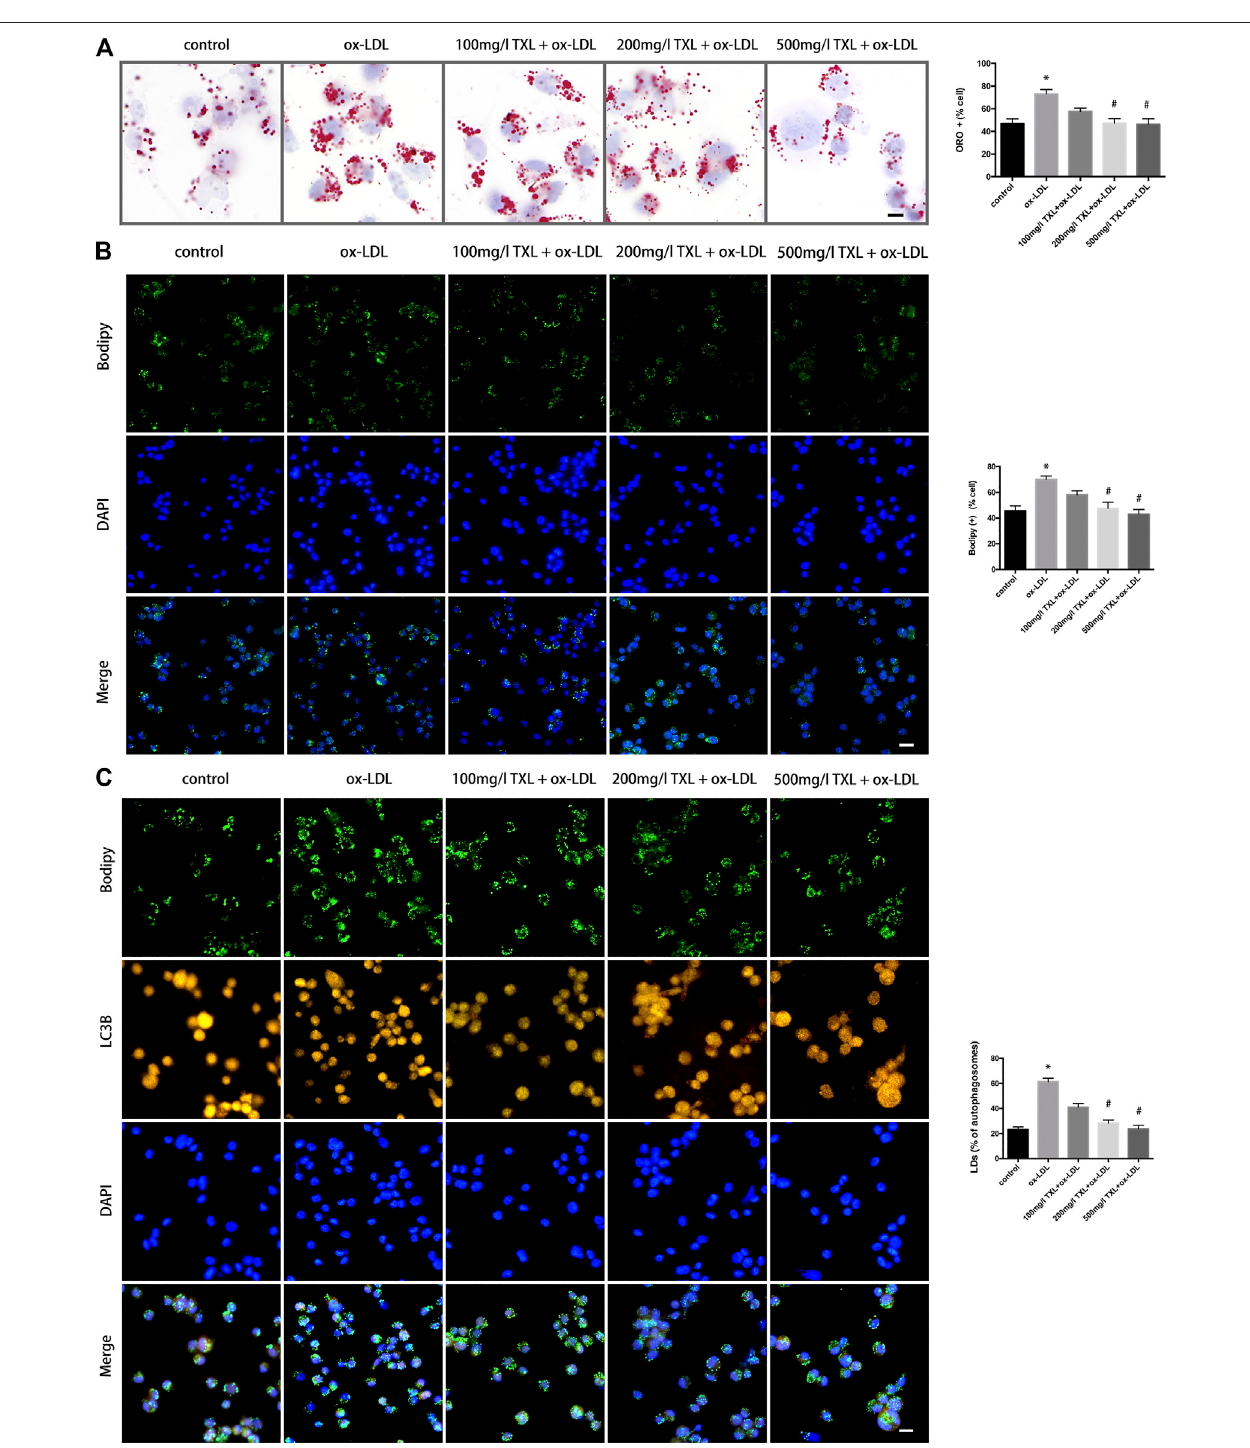
FIGURE 2 | TXL treatment inhibited lipid deposition in THP-1 Macrophages. (A) Cell oil red O detected the effect of TXL on ox-LDL-induced macrophage lipid deposition, n (cid:2) 3, bar (cid:2) 10 μ m, * p < 0.05 vs. control, # p < 0.05 vs. ox-LDL. (B) Cell Bodipy staining detected the effect of TXL on ox-LDL-induced macrophage lipid deposition, n (cid:2) 3,bar (cid:2) 25 μ m,* p < 0.05vs.control, # p < 0.05vs.ox-LDL. (C) EffectsofTXLonautophagyandintracellularlipidinmacrophages. n (cid:2) 3,bar (cid:2) 10 μ m* p < 0.05 vs. control, # p < 0.05 vs. ox-LDL.